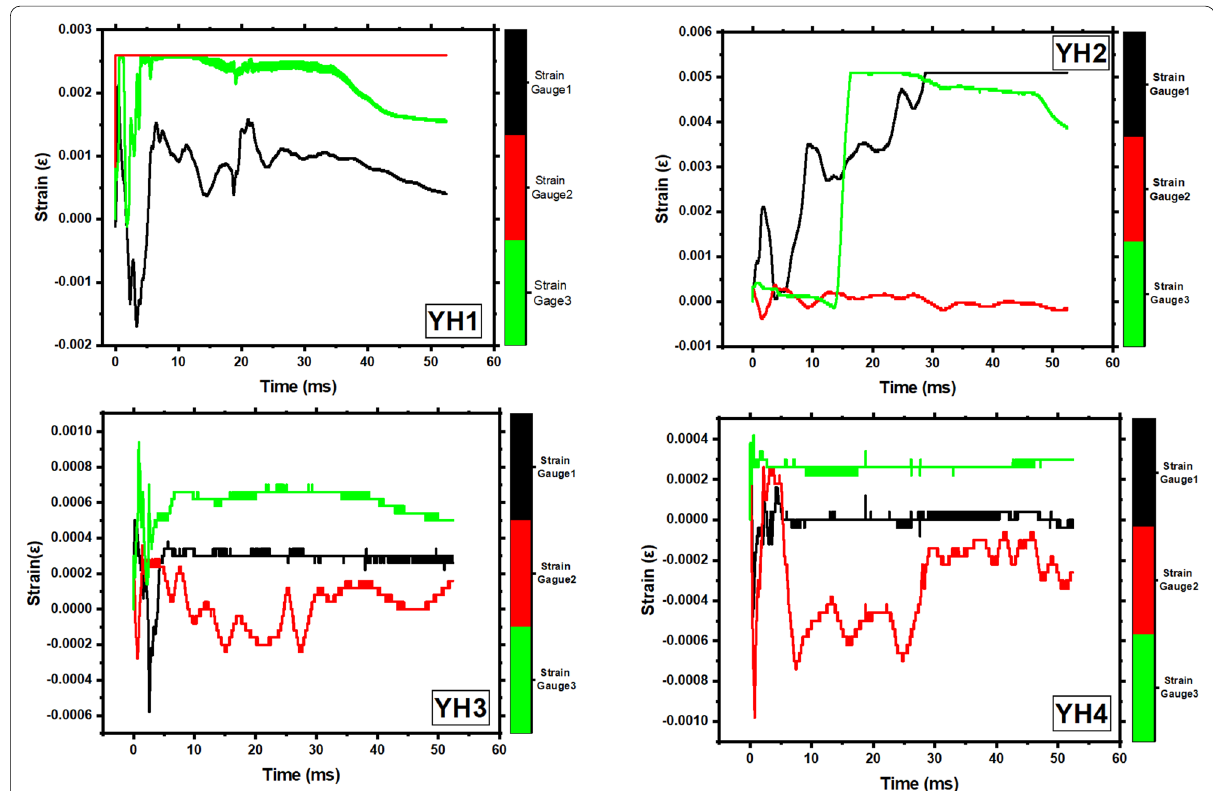
Fig. 17 Strain time history curve.